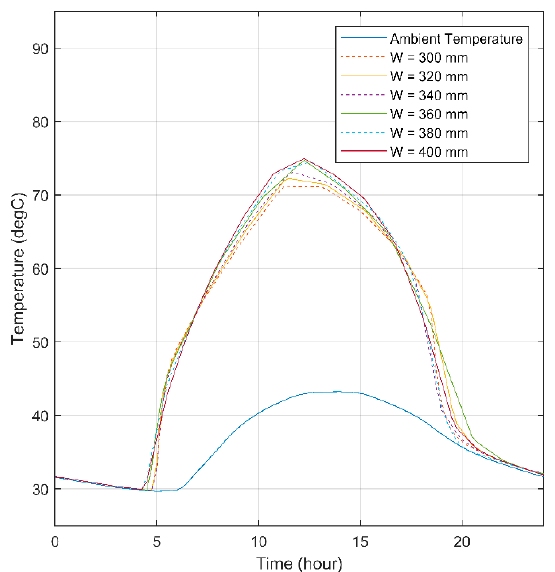
Figure 14. Midpoint temperature for triangular SHC for different values of aperture width.